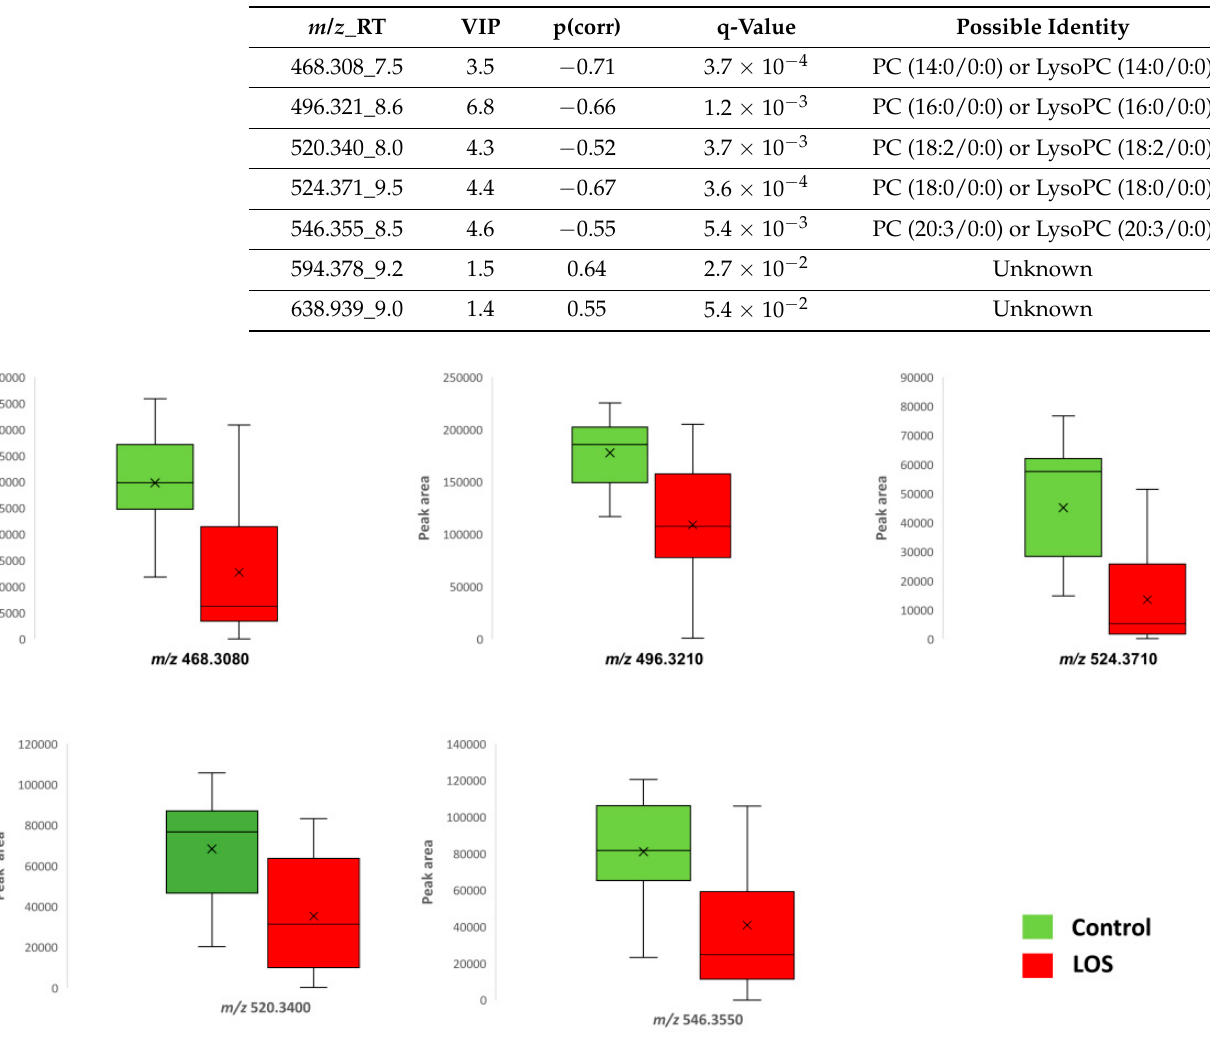
Table 1. Statistically significant features with their respective q-value (Bonferroni), p(corr), and VIP values.